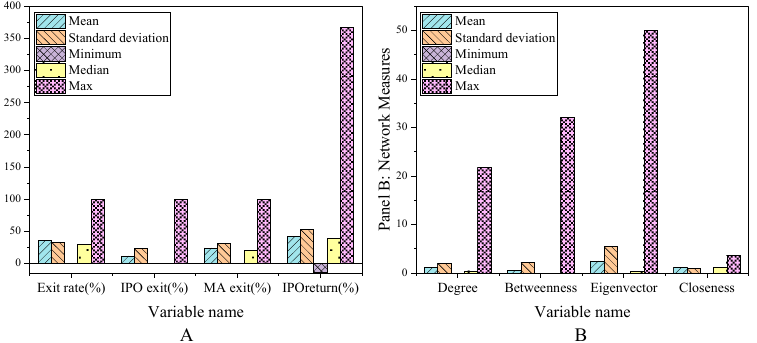
Figure 2. Descriptive statistical results of the main variables in the sample interval ( A ) Panel A; ( B ) Panel B.